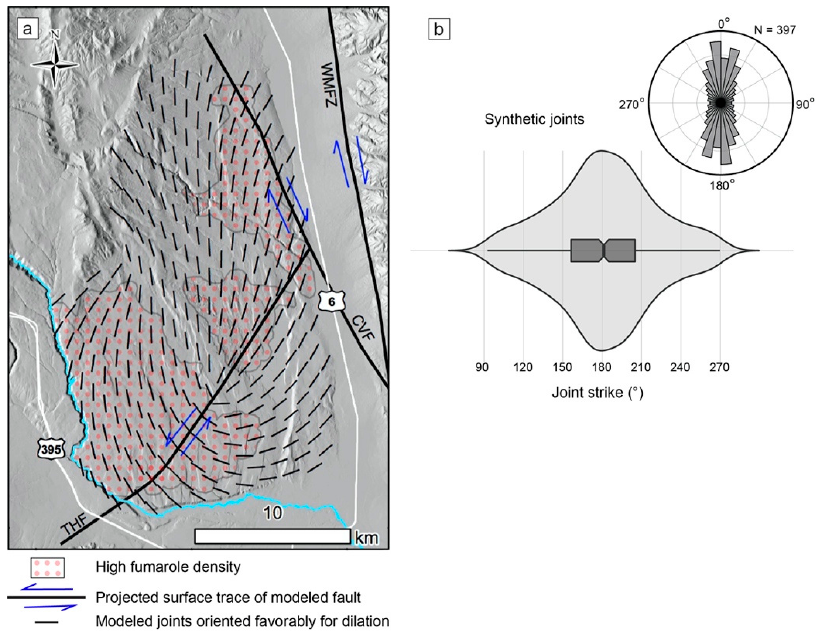
Figure 11. Model output of joints oriented optimally for dilation. ( a ) Map showing joint orientations and the surface projections of the three fault surfaces with respect to areas of highest fumarole density. The sense of slip along each fault plane is indicated with blue arrows according to the motion described by Smith and Priestly [29]. ( b ) Modeled joints oriented optimally for dilation show a bimodal distribution of NE- and NW-striking orientations with an average optimal strike of 181 ◦ . The probability density function of the synthetic joints is distributed such that there is a sharp increase in the likelihood strike values between 150 ◦ and 210 ◦ . Note the similarity of modeled violin and rose plots to that of the mineralized joints recorded in the field (Figure